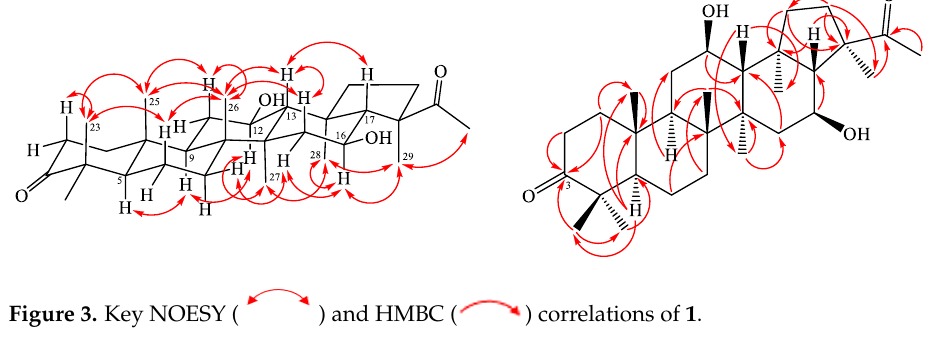
Spergulagenin C ( 2 ) was obtained as colorless needle crystal. Its molecular formula, C 30 H 46 O 4 , was confirmed by the positive HR-ESI-MS at m / z 470.3409 [M] + (calculated for C 30 H 46 O 4 , 470.3406) and supported by the 13 C, 1 H, and DEPT NMR data. IR absorptions for OH (3493 and 3416 cm −1 ) functions were observed. The presence of the acetyl group was supported by a band at 1690 cm −1 in the IR spectrum and was affirmed by signal at δ 25.9, and δ 217. 0 in the 13 C-NMR spectrum. The 13 C- and 1 H-NMR data of 2 revealed the acetyl group [δ H 2.24 (3H, s, H- 30); δ C 25.9 (C-30) and 217.0 (C-22)] and seven methyl signals [ δ H 1.01 (3H, s, H-27), 1.04 (3H, s, H-28), 1.08 (3H, s, H-25), 1.09 (3H, s, H-23), 1.11 (3H, s, H- 26), 1.14 (3H, s, H-24), and 1.45 (3H, s, H- 29); δ C 17.1 (C-25), 17.2 (C-26), 18.8 (C-28), 18.9 (C-27), 21.4 (C-23), 21.1 (C-29) and 27.8 (C-24)]. The 1 H- and 13 C-NMR data of 2 were sim- ilar to those of 1 , except that the double bond at C-1,2 [ δ H 5.83, 7.10 (each 1H, each d, J = 10.0 Hz, H-2 and H-1); δ C 125.6 (C-2), 158.5 (C-1)] of 2 replaced C-1,2 single bond [ δ H 1.41, 1.94 (each 1H, m, H-1), 2.42, 2.48 (each 1H, m, H-2); δ C 34.0 (C-2), 39.4 (C-1)] of 1 . This was supported by the HMBC correlations between H-1 ( δ H 7.10) and C-3 ( δ C 205.3), C-4 ( δ C 39.2), C-5 ( δ C 53.3), and C-9 ( δ C 42.7); and between H-2 ( δ H 5.83) and C-4 ( δ C 39.2) and C- 10 ( δ C 44.6). The NOESY cross-peaks between H-5/H-9, H-9/H-12, H-12/H-27, H-13/H-17, H-13/H-26, H-16/H-29, H-23/H-25, H-25/H-26, H-27/H-28, and, H-28/H-29 suggested that H-13, H-17, Me (23), Me (25) and Me (26) are on the β -side and H-5, H-9, H-12, H-16, Me (27), Me (28 ) and Me (29) are on the α -side of 1 . The full assignment of 13 C- and 1 H-NMR resonances was confirmed by 13 C-DEPT (Figure S12), 1 H – 1 H COSY (Figure S13), NOESY (Figures 4 and S14), HSQC (Figure S15), and HMBC (Figures 4 and S16) techniques. The absolute configuration of 2 was evidenced by the ECD Cotton effects at 283 (Δε +0. 96), 249 (Δε − 0.14), 219 (Δε + 1.05), and 198 (Δε − 1.09) nm, in analogy with those of 1 and glinusop- poside D [11]. On the basis of the evidence above, the structure of 2 was elucidated as (3 R ,4 S ,5a R ,5b R ,11a R ,13 R ,13b R )-3-acetyl-4,13-dihydroxy-3,5a,5b,8,8,11a,13b-heptame- thyl-1,2,3,3a,4,5,5a,5b,6,7,7a,8,11a,11b,12,13,13a,13b-octadecahydro-9 H -cyclopenta[a] chrysen-9-one, named spergulagenin C.